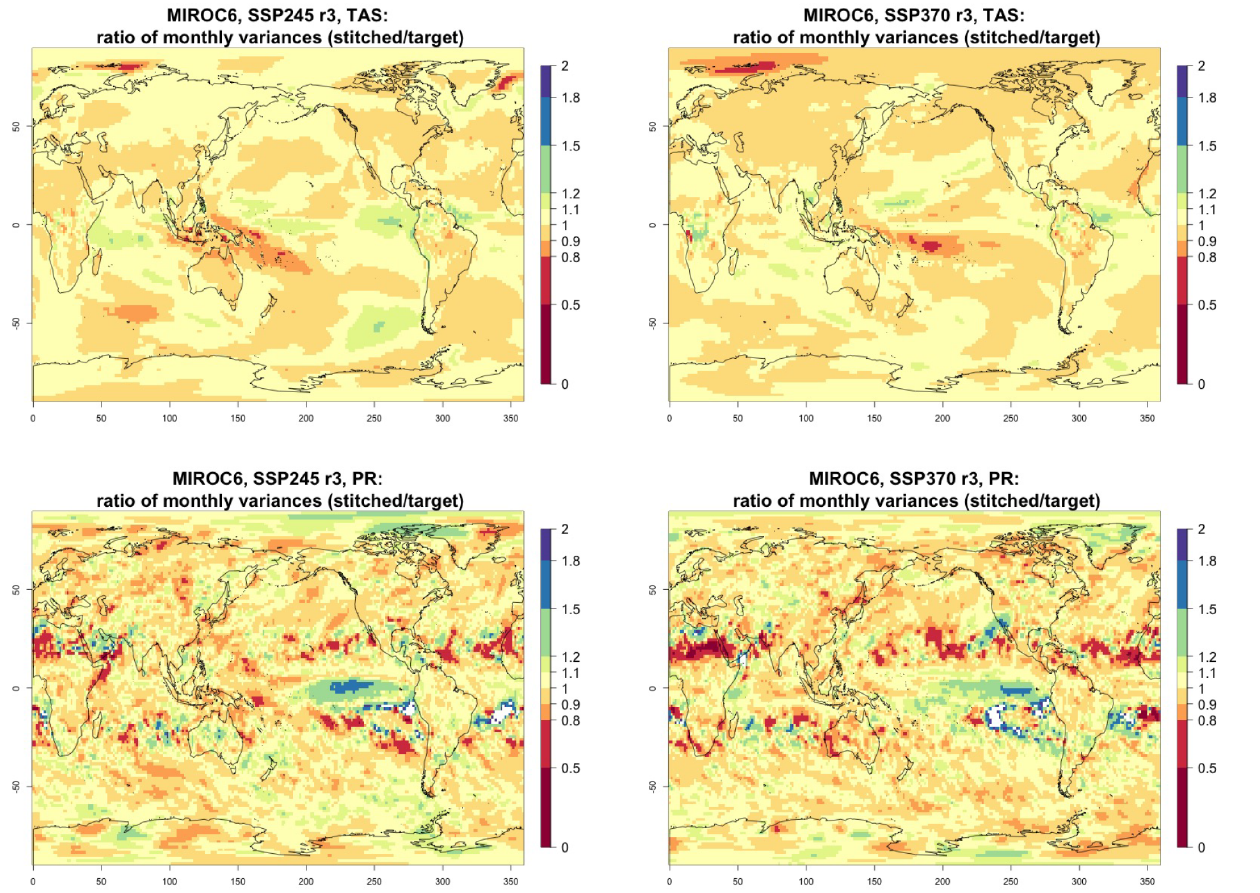
Figure C10. Ratio of monthly variability (standard deviation of residuals from trends) in temperature (TAS) and precipitation (PR) between stitched (at the numerator) and target (at the denominator) time series. The value of the ratio is expressed by the color scale, which highlights the transitions at 0.8 and 1.2. Emulation of MIROC6, monthly time series over 2015–2100, for SSP2-4.5 and SSP3-7.0. Third realization.